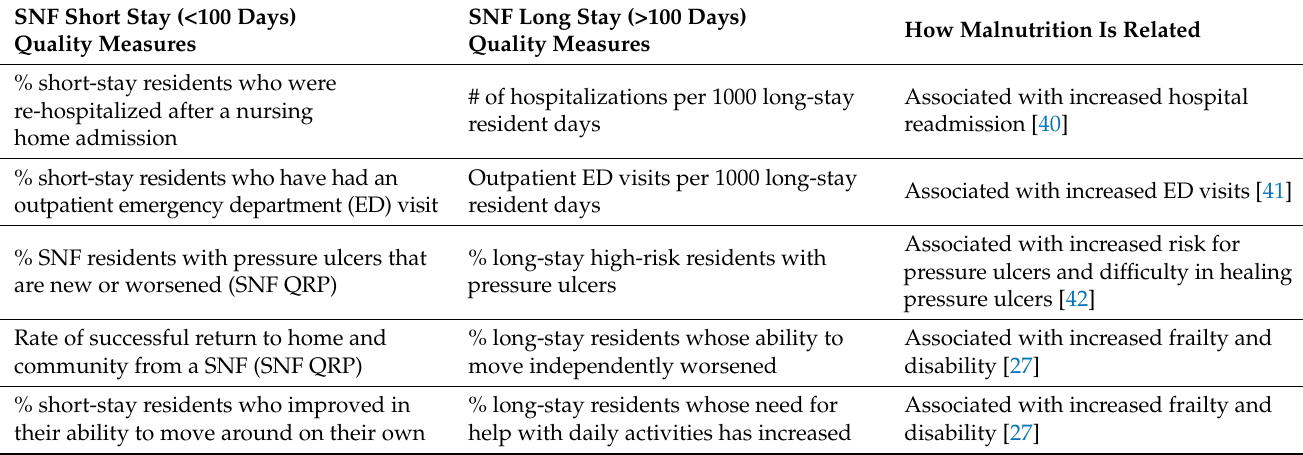
Table 1. Skilled Nursing Facility (SNF) Centers for Medicare & Medicaid Services (CMS) quality measures [19] potentially related to